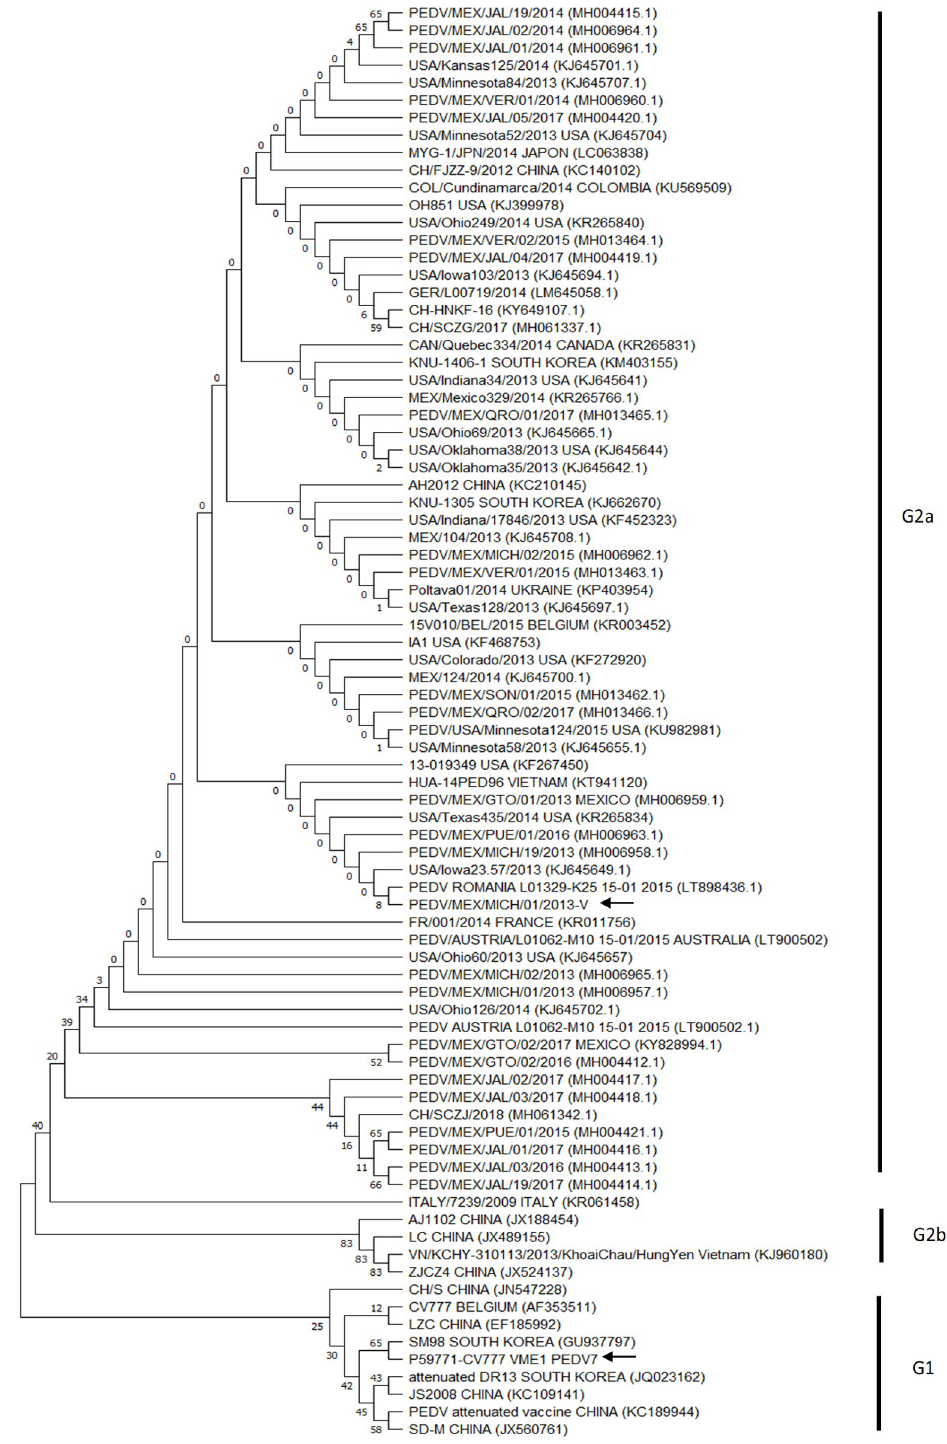
Fig 1. Phylogenetic tree built with 87 sequences of the M protein of the PEDV from Mexico, United States of America, Europe and Asia. The amino acid sequences of M protein were clustered into three groups related to G2a, G2b, G1 strains of PEDV. The arrows signal the two sequences chosen to generate the 3D model of the M protein. The evolutionary history was inferred using the Neighbor-Joining method. Details and references are provided in Material and Methods